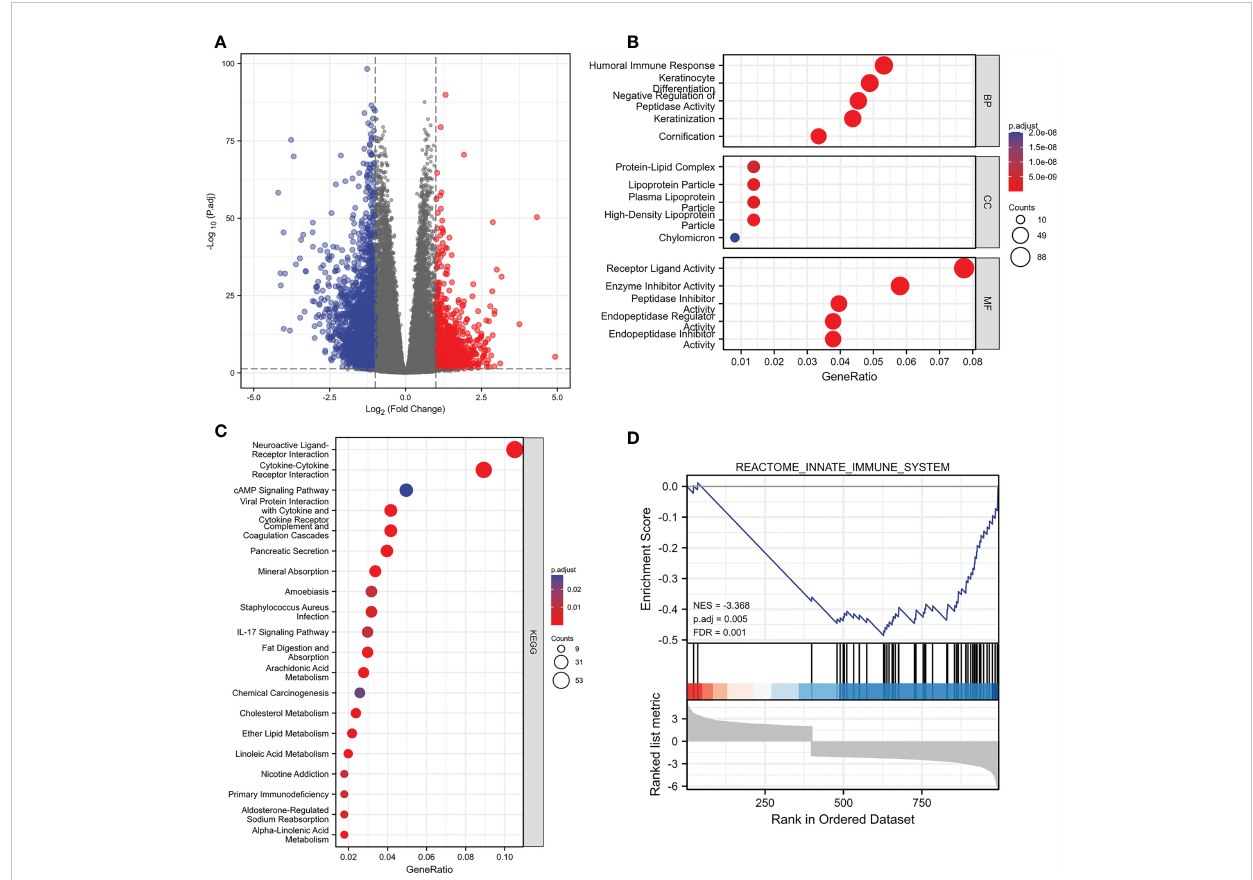
FIGURE 6 The changes of genes and biological processes caused by the PIK3C2A alteration in KIRC. (A) The volcano plot shows the differential expression genes between PIK3C2A high-expression and low-expression groups in KIRC. (B, C) The bubble charts visualize the results of GO term and KEGG pathway enrichment analysis of the differential expression genes. (D) The GSEA results of the differential expression